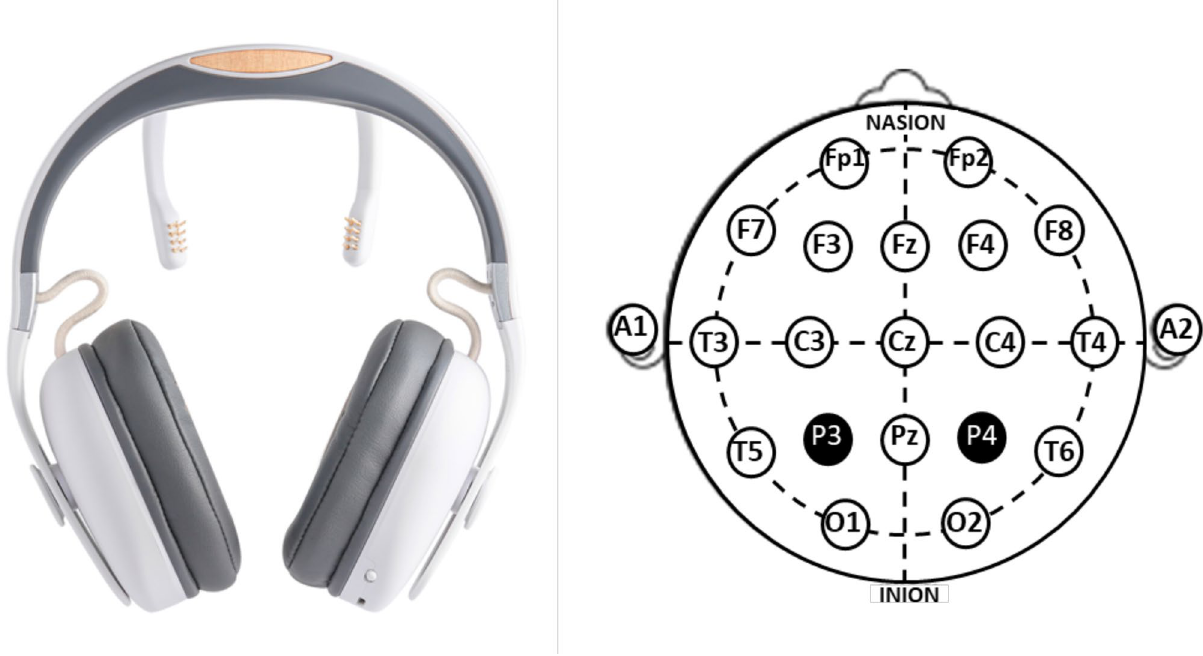
Figure 1. Melomind device. Left: The device comprises an audio headset and two posterior branches at the end of which two gold-coated dry electrodes are inserted. Right: These electrodes are positioned at P3 and P4 locations (indicated in black) according to the extended 10–20 International